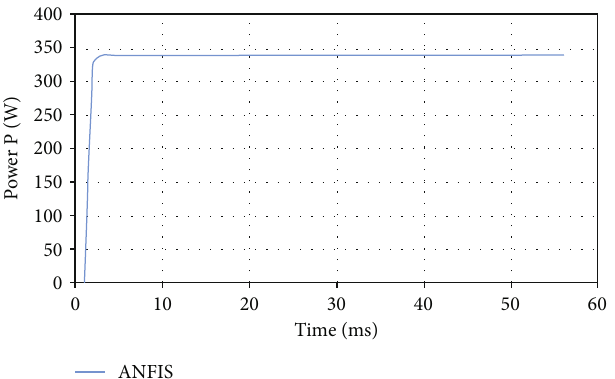
Figure 15: Output power of the ANFIS MPPT at PSC I.